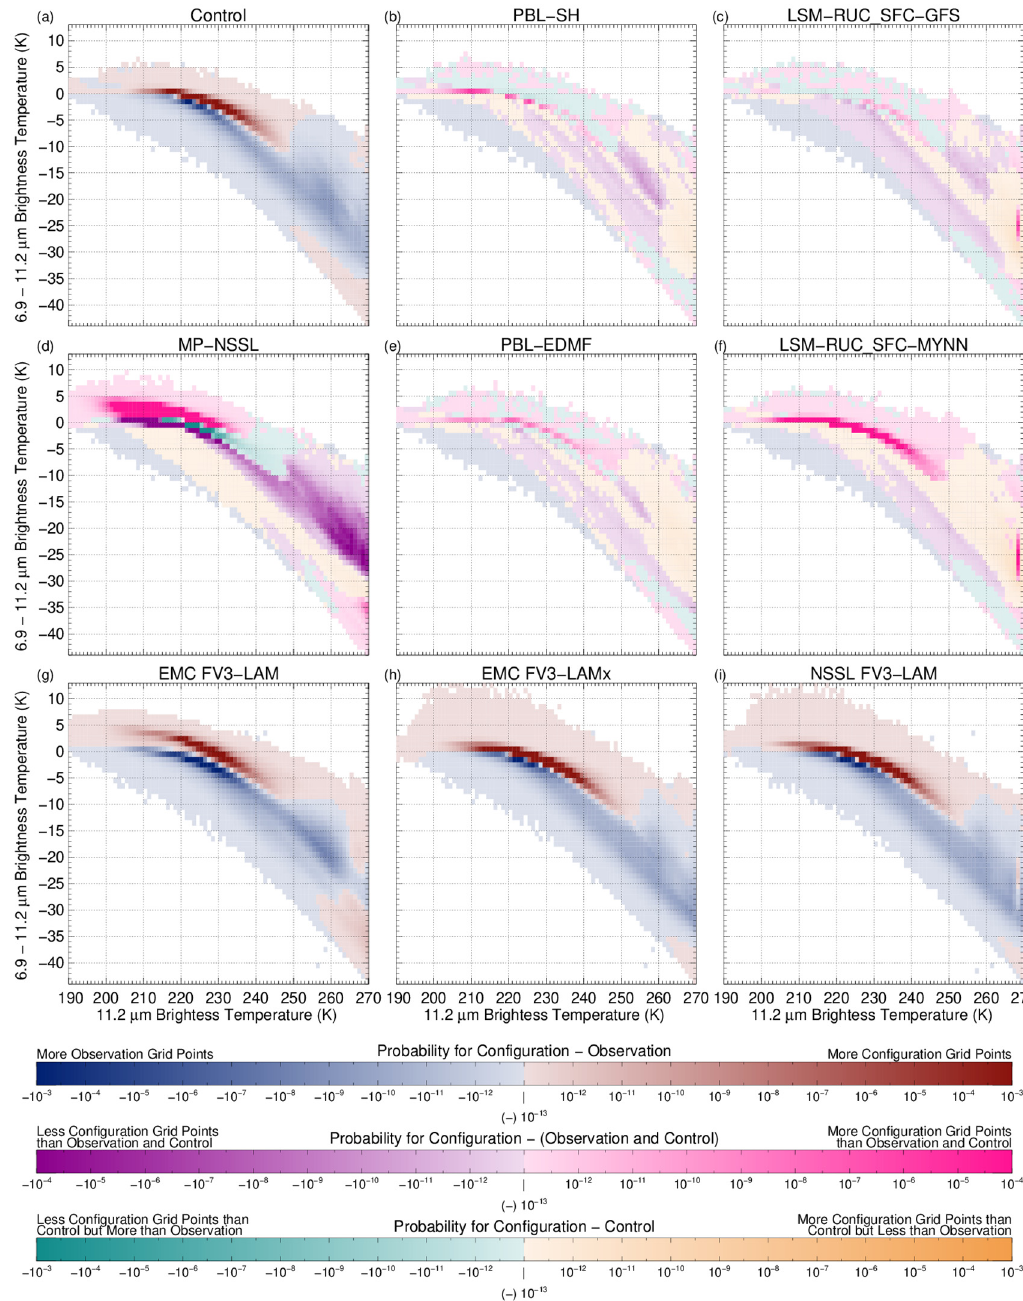
Figure 7. Histograms of GOES ‐ 16 ABI 6.9–11.2 μ m brightness temperature differences plotted as a function of the ABI 11.2 μ m brightness temperature ( a – i ). Red (blue) shading in the first color bar indicates a higher (lower) number of grid points with a given BTD and 11.2 μ m BT combination for the configuration compared to the observations. Purple (pink) shading in the second color bar indicates a given configuration has fewer (more) grid points at the given BTD and 11.2 μ m BT combination than both the observations and Control. In the third color bar, green indicates the configuration also has more grid points than the observations for a given combination but fewer than Control, while orange indicates that the configuration has more grid points than Control but fewer than the observations.